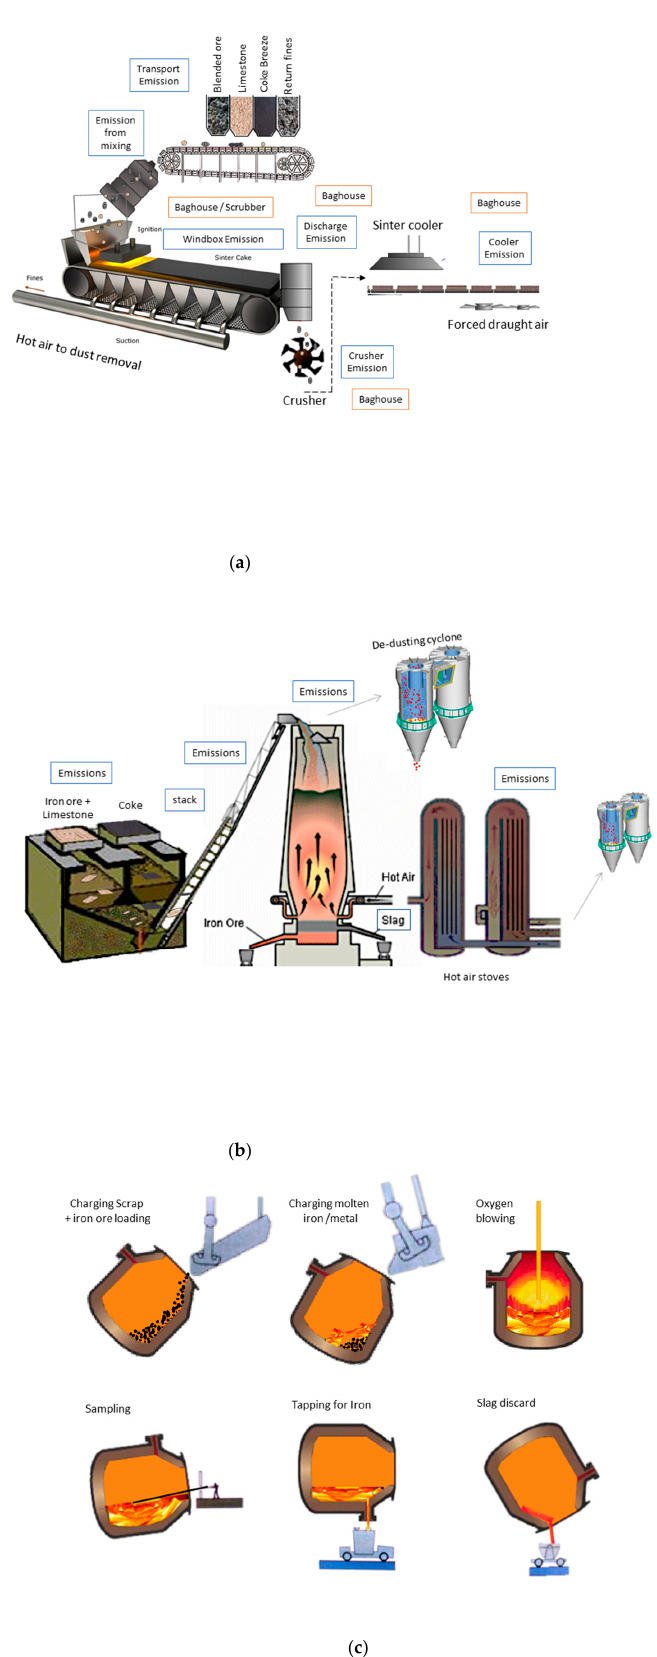
Figure 1. Schematic diagram of steel production highlighting process by-product emissions points in typical steel plant operations: ( a ) Sinter plant; ( b ) blast furnace and ( c ) basic oxygen furnace (a generic summary based on industry process descriptions and site visits to a number of manufacturing plants).